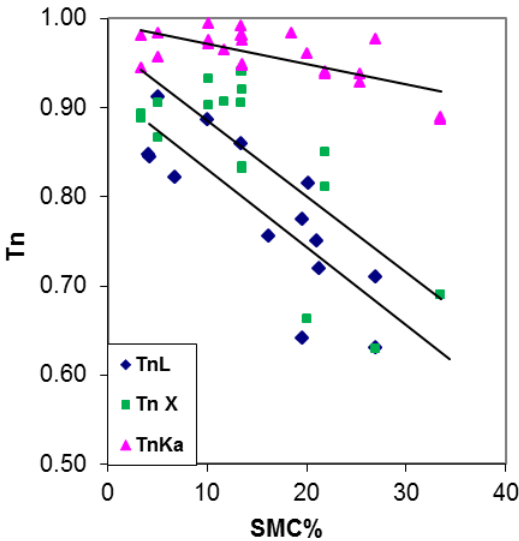
Figure 2. The normalized Temperature (Tn, i.e., the ratio between brightness temperature, and thermal surface temperature, at Ka, X, and L as a function of SMC% of a bare smooth sandy soil. Also polarization is influenced by the moisture content. The behavior of the Polarization Index (the difference between the vertical, V, and horizontal, H, components of Tb normalized to their average value), PI = (Tbv − Tbh)/(1/2) (Tbv + Tbh) at L and X bands vs. SMC is represented in the